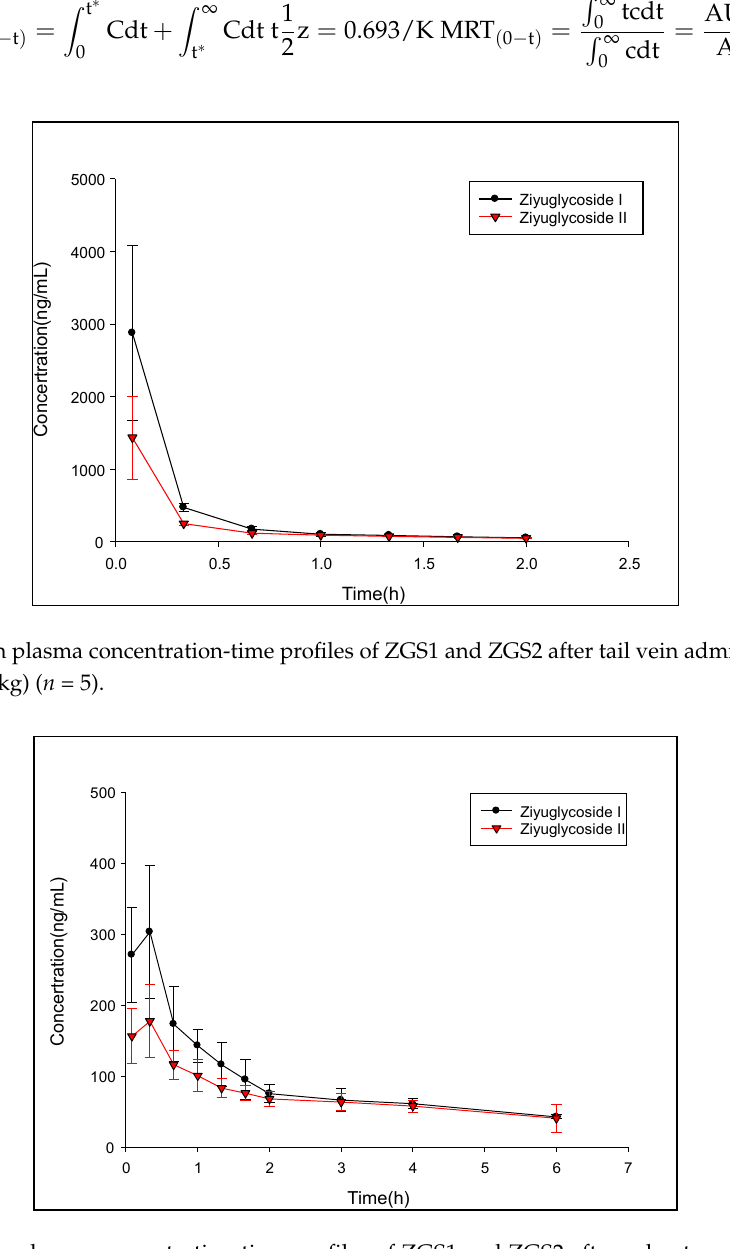
Figure 5. Mean plasma concentration-time profiles of ZGS1 and ZGS2 after subcutaneous injection administration of ZGS1 (10 mg/kg) ( n = 5). Table 7. Pharmacokinetic parameters of ZGS1 and ZGS2 in rats after tail vein administration of 10 mg/kg ZGS1 ( n =